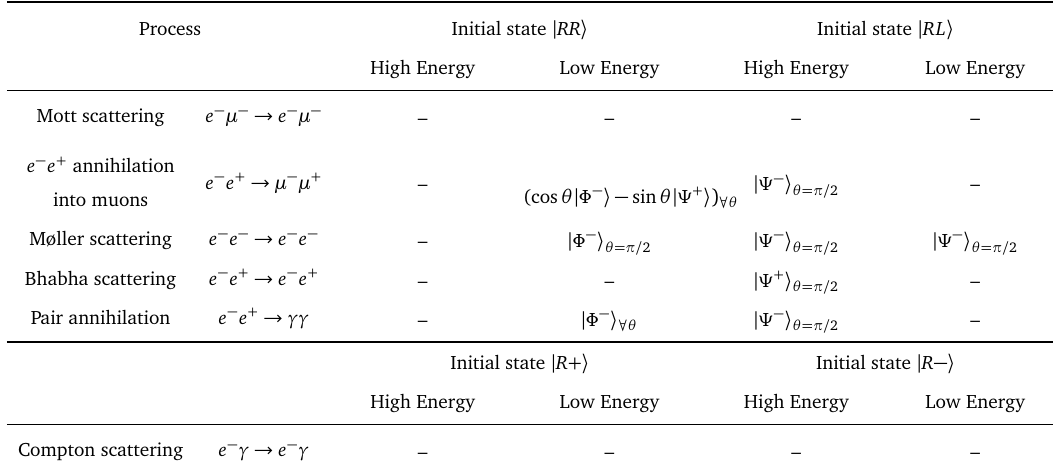
Table 1: Maximally-entangled states ( ∆ = 1) for tree-level QED processes, both in the high- and low-energy limits. The states are written in terms of the Bell basis, | Φ ± 〉 ∼ | RR 〉±| LL 〉 and | Ψ ± 〉 ∼ | RL 〉±| LR 〉 . For the processes in the upper part of the table, the initial state is expressed in terms of the helicities of the fermions, R and L . For Compton scattering, e − γ → e − γ , the initial state is expressed in terms of the helicity of the electron and the polarization of the photon, | + 〉 or |−〉 . The scattering angle where the entangled state is produced is indicated in the subscript. A dash indicates that MaxEnt cannot be reached for any value of the scattering angle θ